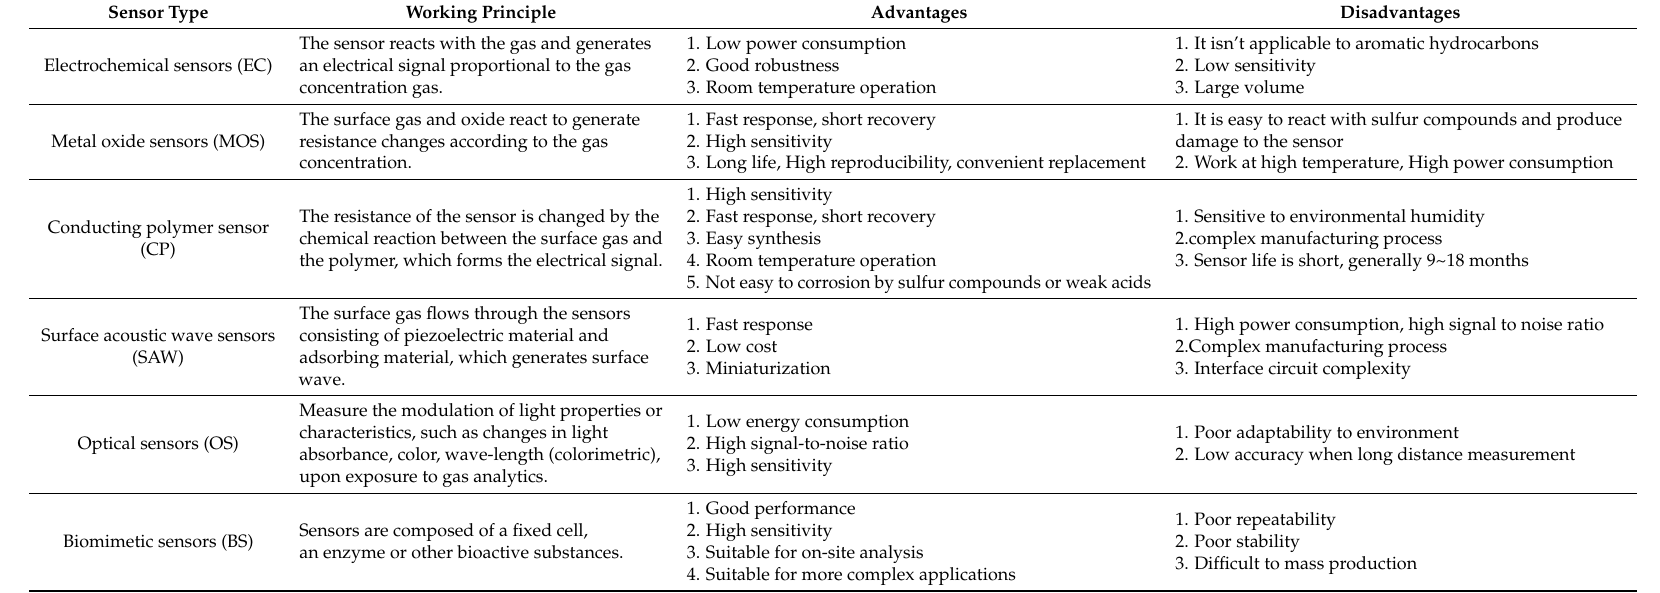
Table 2. Comparison of characteristics of sensors utilized in design of E-noses (sensor